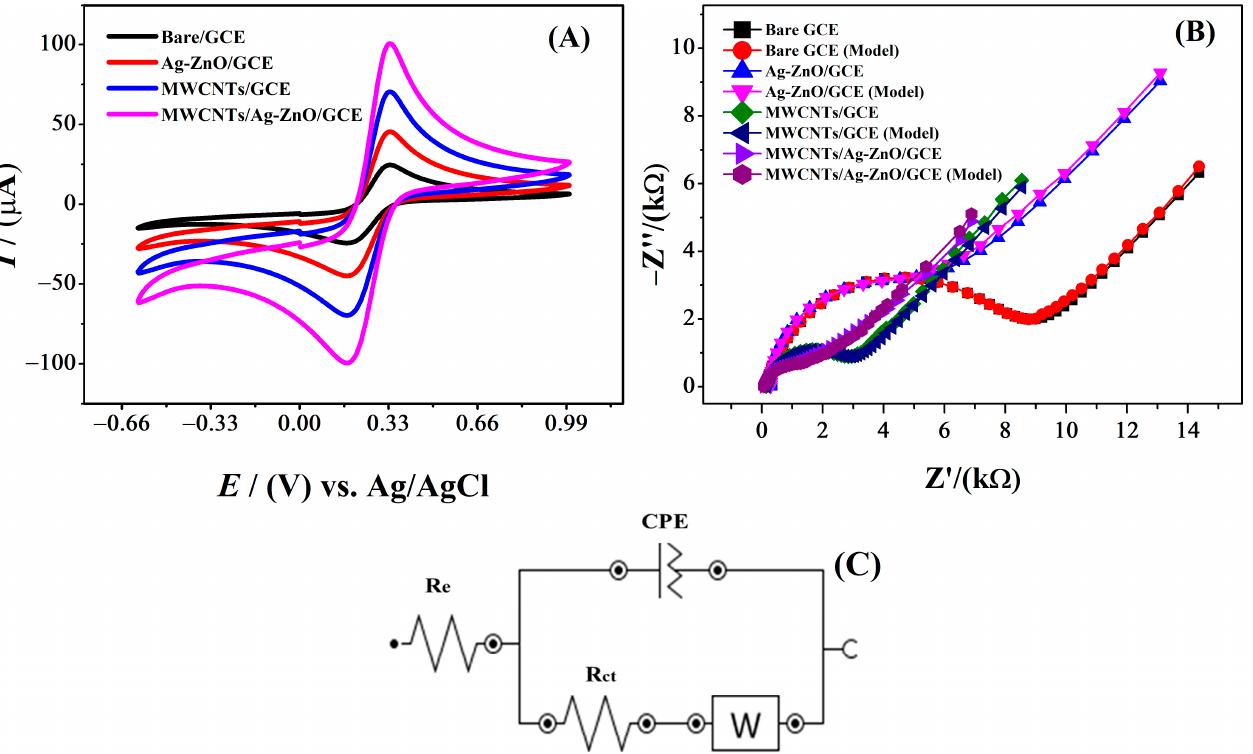
Figure 3. ( A ) Cyclic voltammograms for bare and modified glassy carbon electrodes recorded in 5 mM K 3 [Fe(CN 6 )] with 0.1 M KCl as supporting electrolyte at a scan rate of 100 mVs − 1 ( B ) Nyquist plots of bare and modified GCEs in a solution of 5 mM K 3 [Fe (CN) 6 ] as a redox probe and 0.1 M KCl as a supporting electrolyte, and ( C ) equivalent circuit corresponding to EIS data.